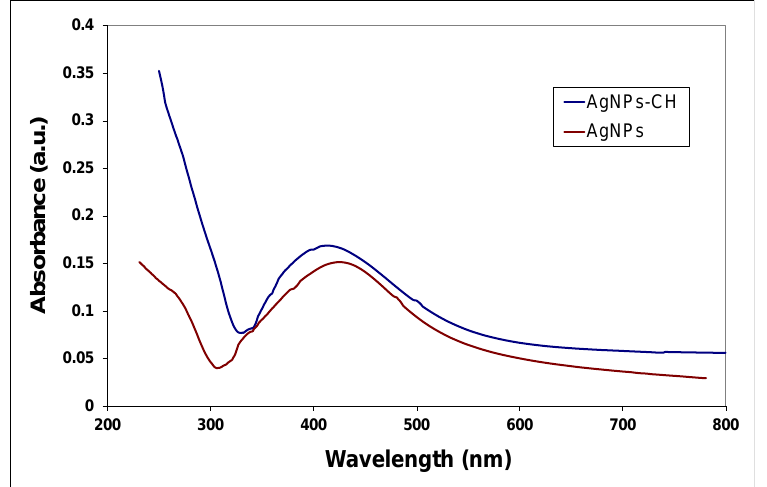
Figure 1. The ultraviolet-visible (UV-vis) spectra of silver nanoparticles (AgNPs) with and without chitosan (CH) stabilizer.